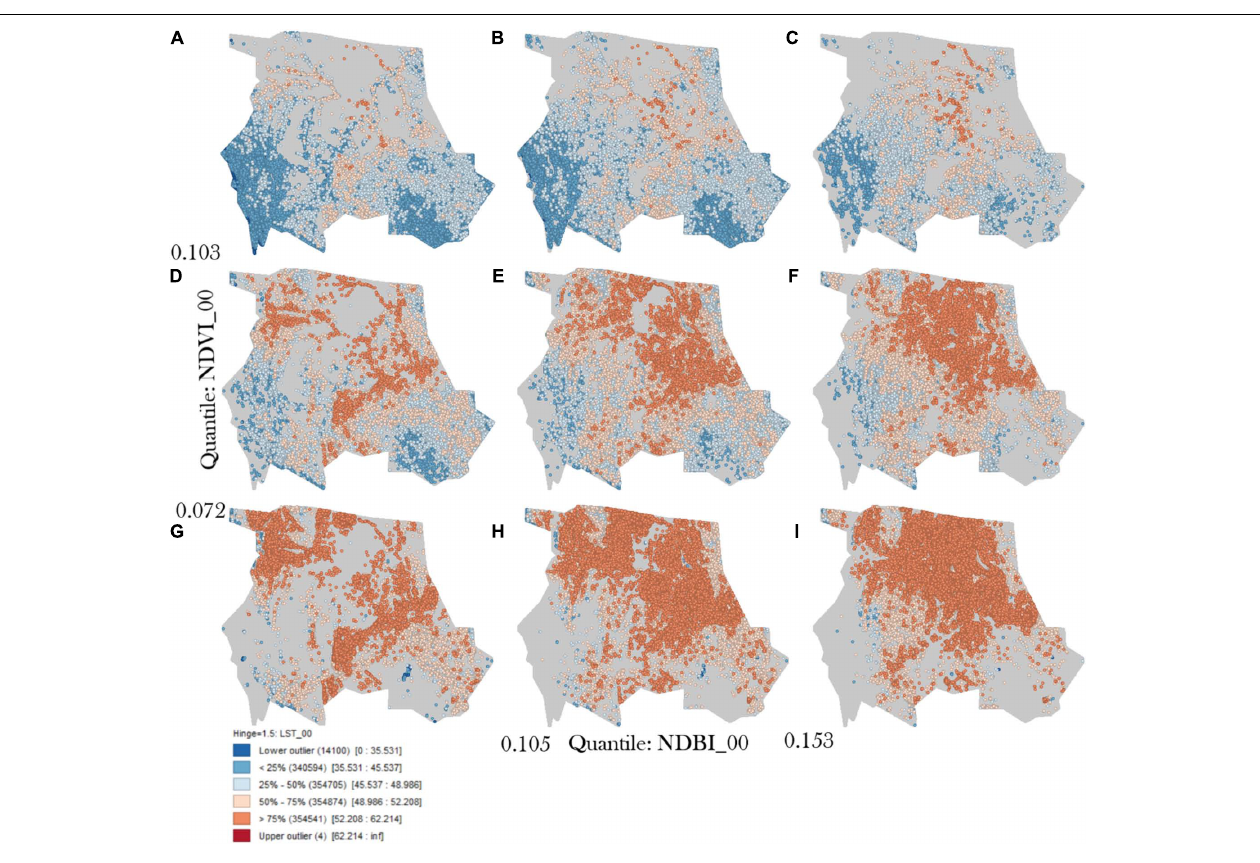
FIGURE 8 | (A–I) Conditional map of LST based on NDBI and NDVI for